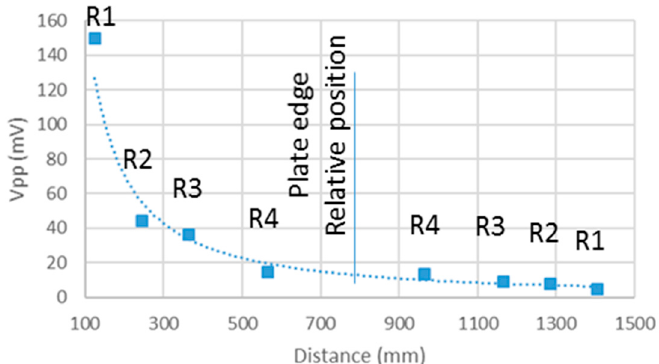
Figure 5. Peak-to-peak voltage measurements of the waves acquired in each PWAS on the direct path along the specimen (R1 to R4) and on the path after the reflection on the opposite plate end (R4 to R1).